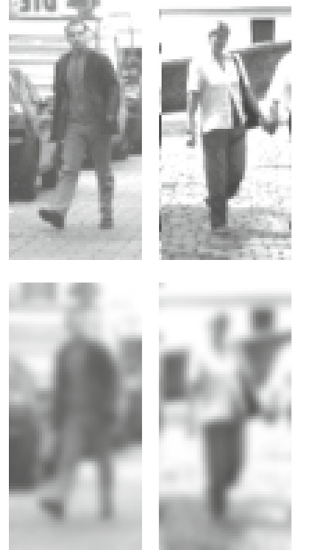
Fig. 10 PDCdatasetimageflipping,inwhichthefirstlineistheoriginal image, and the second line is the new image after the flip processing that the more layers, the higher the accuracy. Therefore, we determined 2G + 2GA as the final model architecture.